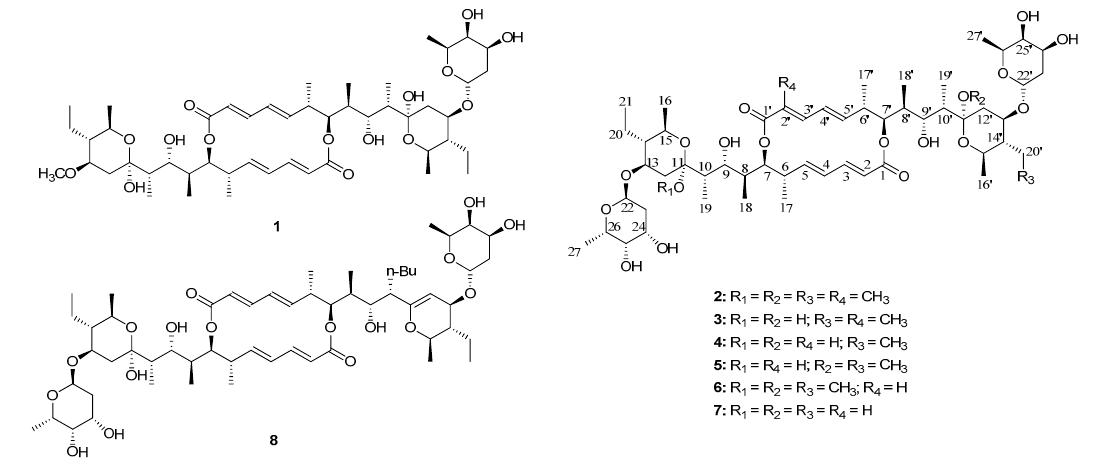
Figure 1. Chemical structures of compounds 1 – 8 .